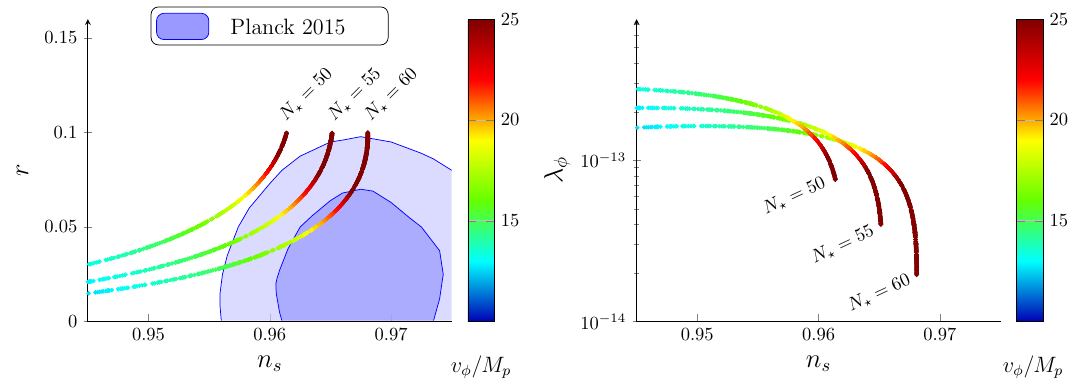
Figure 2 . Left panel: in(cid:13)ation observables for various numbers of e-folds and arbitrary value of the vev v (cid:30) (colorbar). Right panel: value of the quartic coupling (cid:21) (cid:30) imposed by the COBE normalization, as a function of the tilt n s and the in(cid:13)aton vev v (cid:30) (colorbar). 3.1